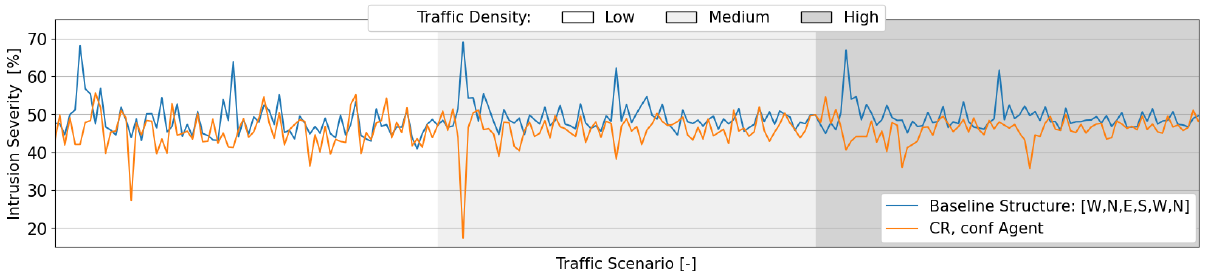
Figure 17. Mean intrusion severity rate. All traffic densities had 75 traffic scenarios, with the initial direction(s) and the number of turns following the same order as shown during the training